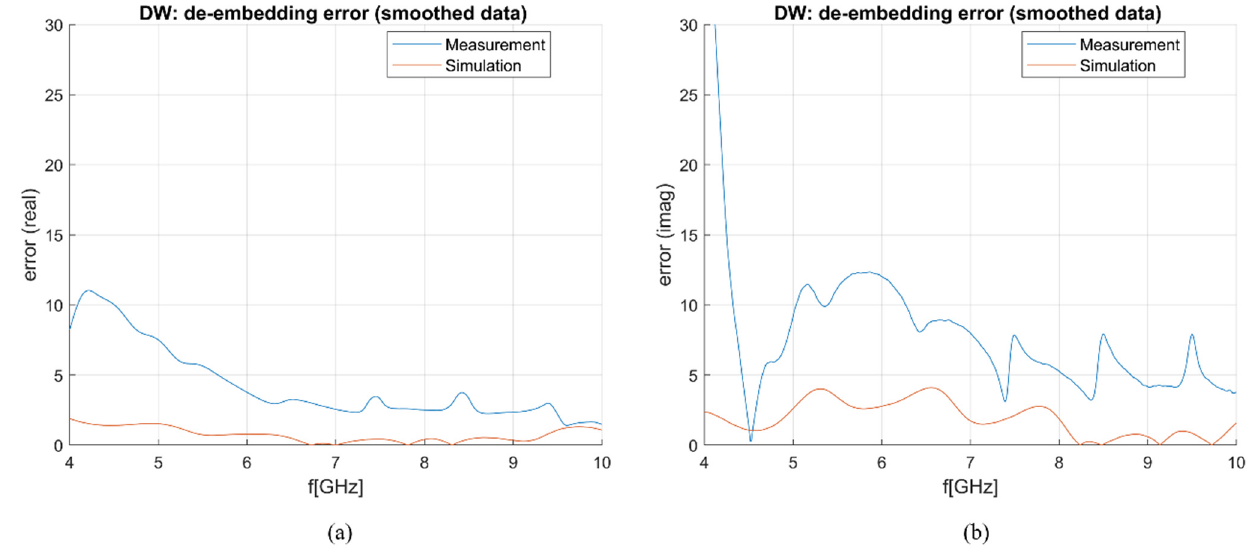
Figure 6. Sensitivity (de-embedding error) comparison between simulation and measurement results: ( a ) ε ’ (“real”); ( b ) ε ’’ (“imag”).